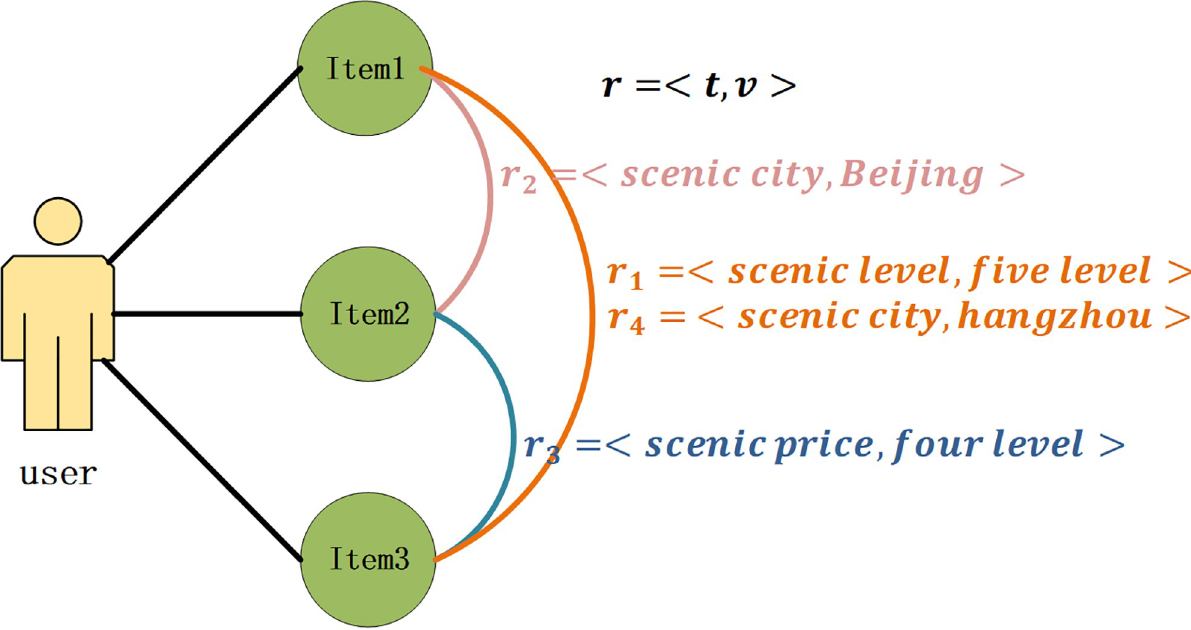
Fig 2. Diagram illustrating the multiple relationships between items in the user interaction history. Each relation r is described by type t and value v . There is a relationship r 2 between Item 1 and Item 2, the relationship type is the scenic city, and the relationship value is Beijing. Multiple relations may also exist between two items.